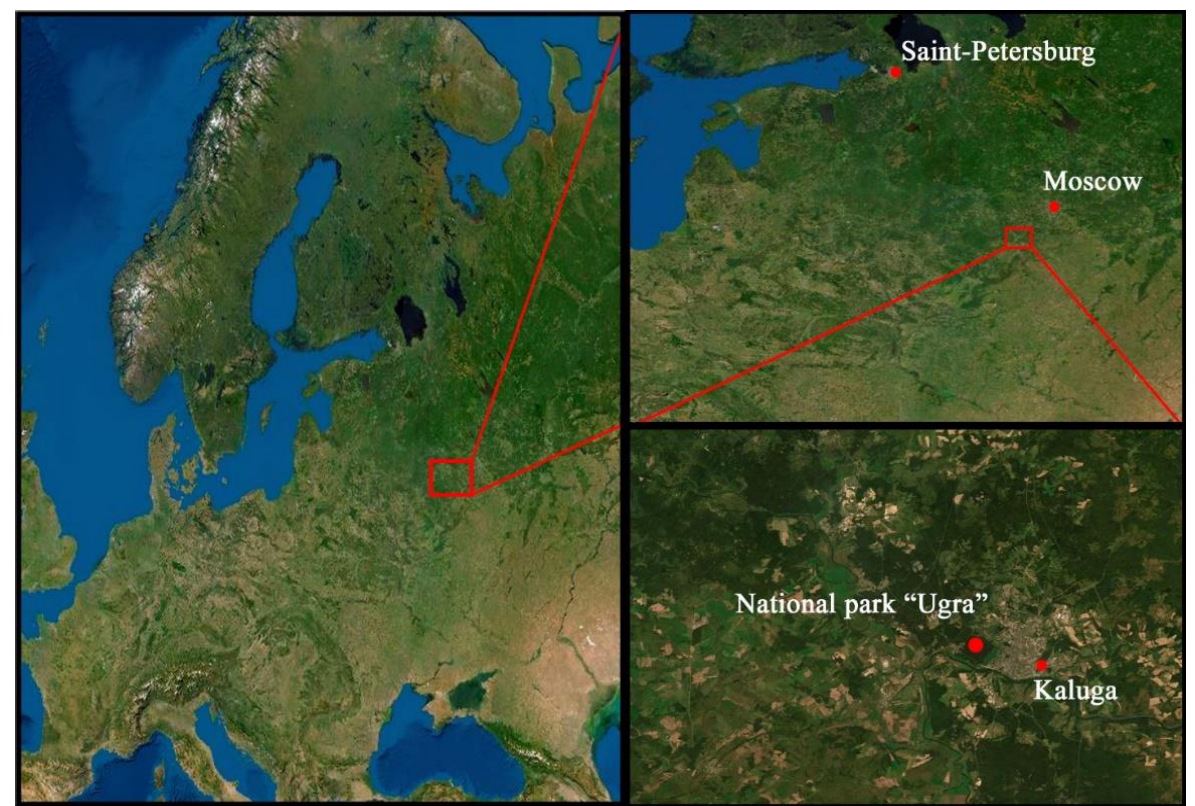
Figure 2. First carbon polygon in Russia. National park “Ugra” (Source: ESRI: Geographic information system company (West Redlands, California, United States of America)).